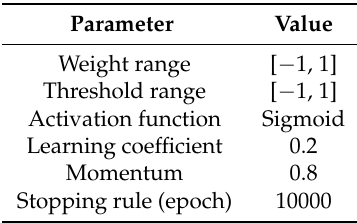
Table 2. Artificial Neural Network